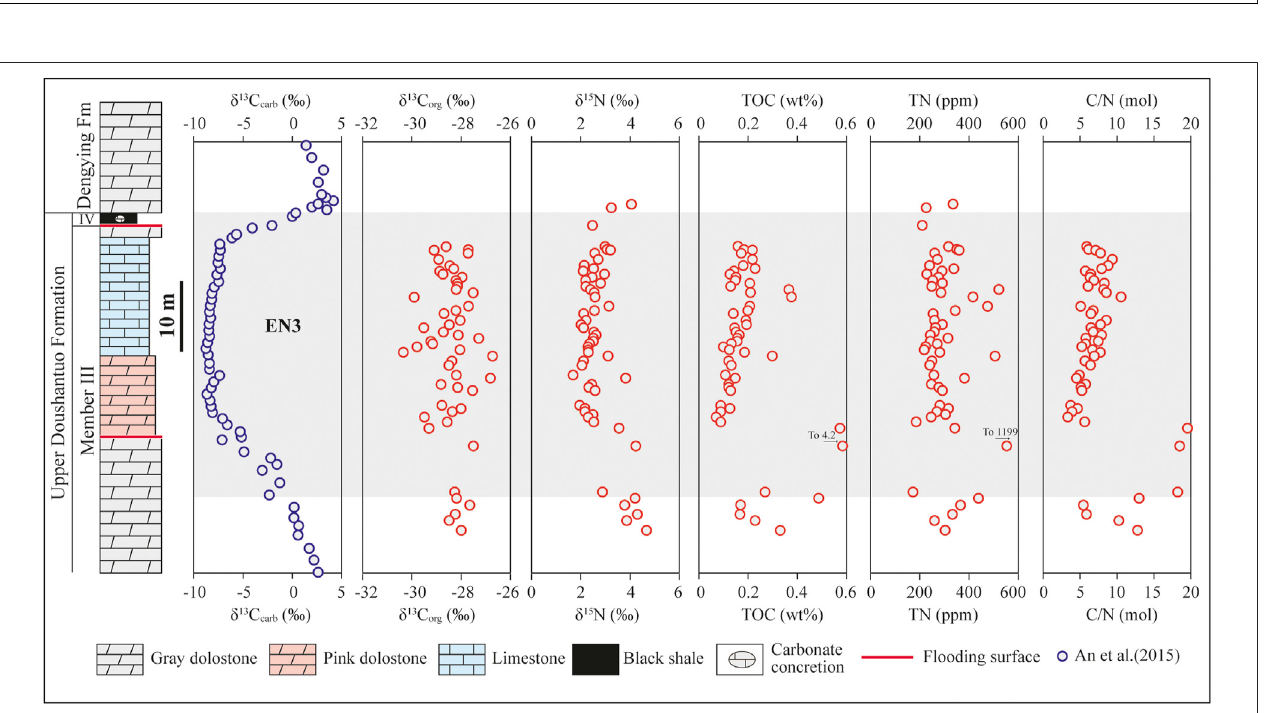
FIGURE 3 | The geochemical pro fi les of δ 13 C carb , δ 13 C org , δ 15 N, TOC, TN and MC/N spanning the Shuram-EN3 excursion in the Xiangerwan section.